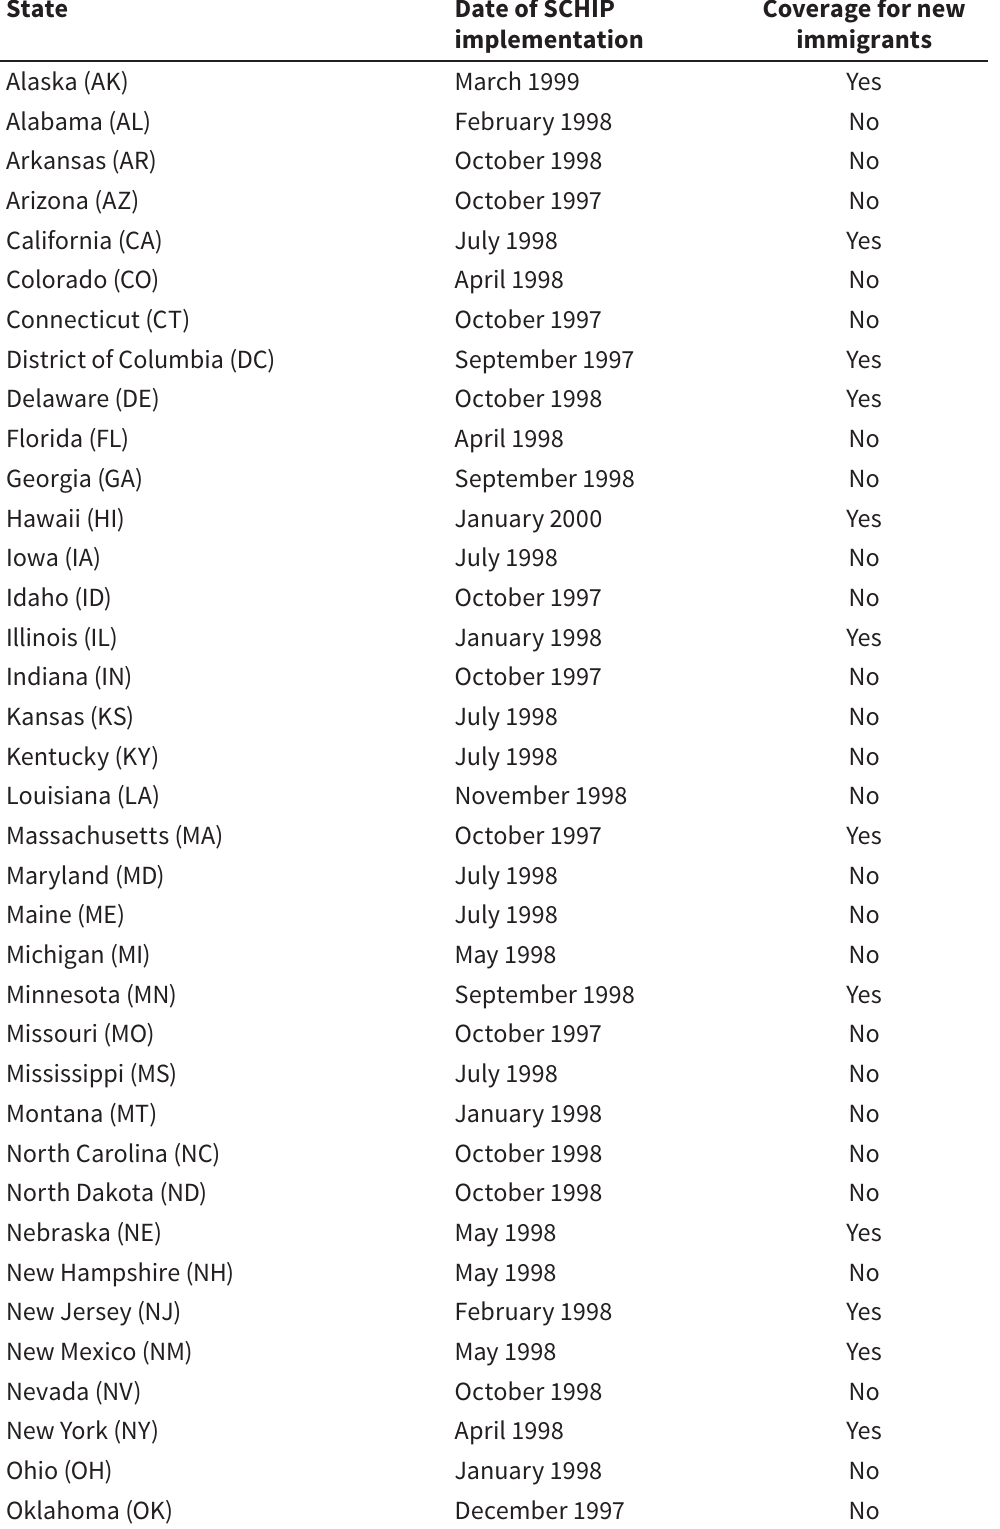
SCHIP Implementation and Immigrant Coverage by